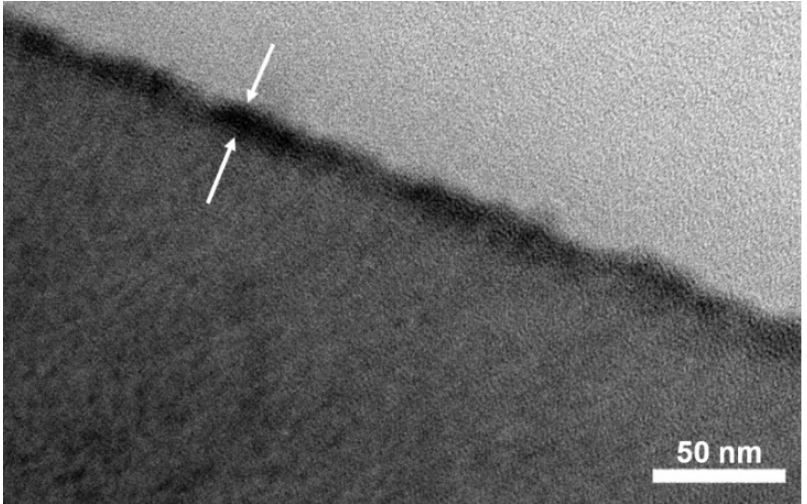
Figure 8. Transmission electron microscopy image of the outermost area of the hollow-fiber mem- brane after CPVA adsorption and cross-linking. White arrows indicate the XCPVA separation layer stained by titanium element. The thickness of the XCPVA layer was ca. 20 nm.